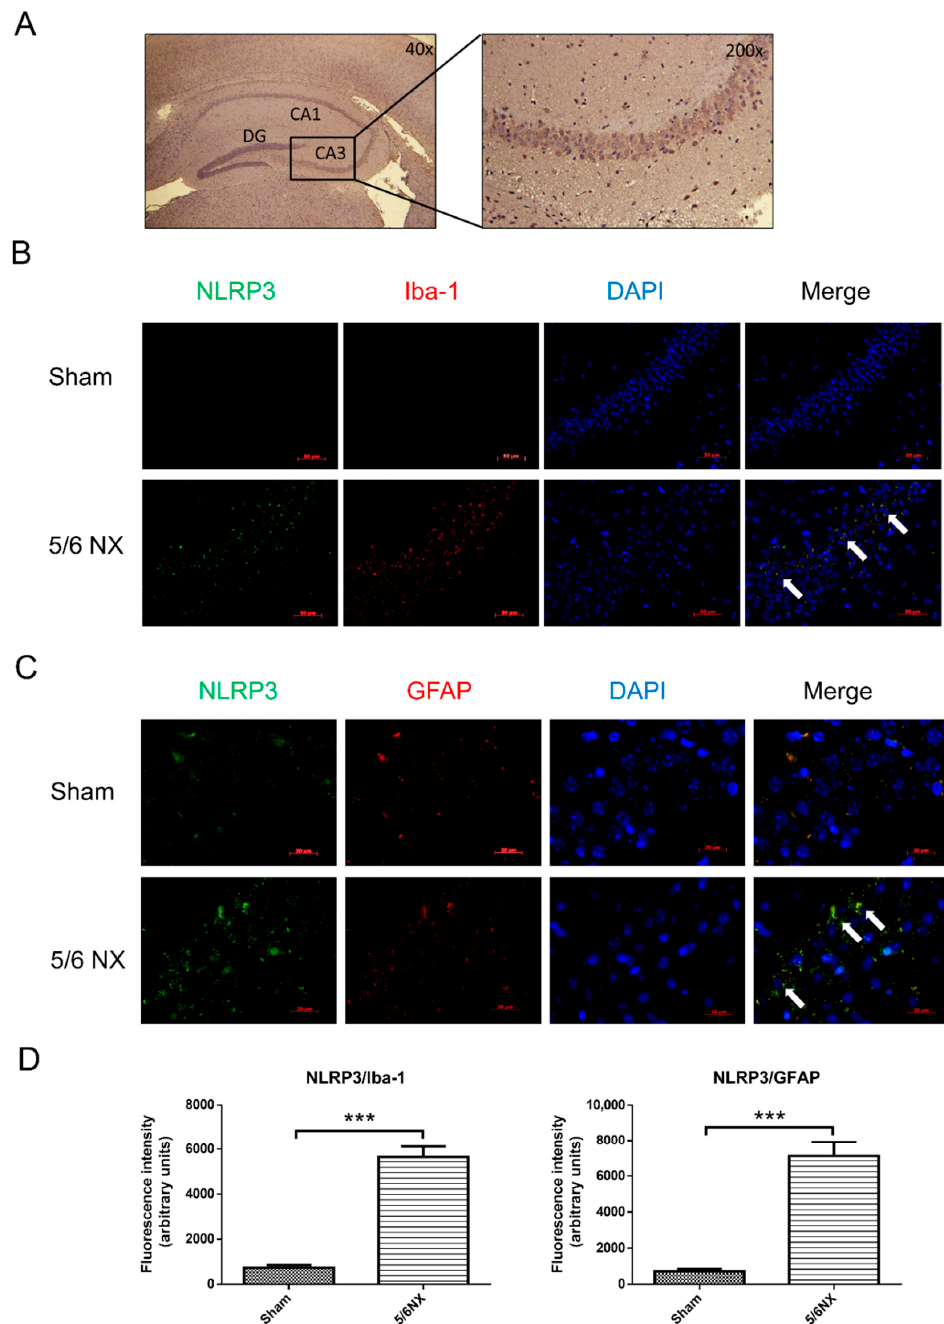
Figure 7. There were increased NLRP3 inflammasomes in hippocampal microglia and astrocytes of CKD mice. Bright light microscopy of hematoxylin stain demonstrated the anatomy of hippocampus with hematoxylin and eosin stain. The following images were in CA3 region of the hippocampus (panel ( A )). The demonstration of Immunohistochemistry staining against Iba-1, GFAP, and NLRP3 was used to examine the inflammatory response in the CA3 of hippocampus in CKD mice, which demonstrated colocalization of NLRP3 foci (green, panel ( A , B )) with Iba-1 (red, panel ( B )) and GFAP (red, panel ( C )). Additionally, the quantitative results of images demonstrated a considerable increase in NLRP3 inflammasomes in both hippocampal microglia and astrocytes of CKD mice comparing with those in sham control mice (panel ( D )). The immunohistochemistry results suggested that hippocampal microglia and astrocytes could yield the inflammatory response to accumulated IS or PCS levels in the CKD mice. DG, dentate gyrus; CA: Cornu Ammonis. (Scale bar 50 µ m; *** p ≤